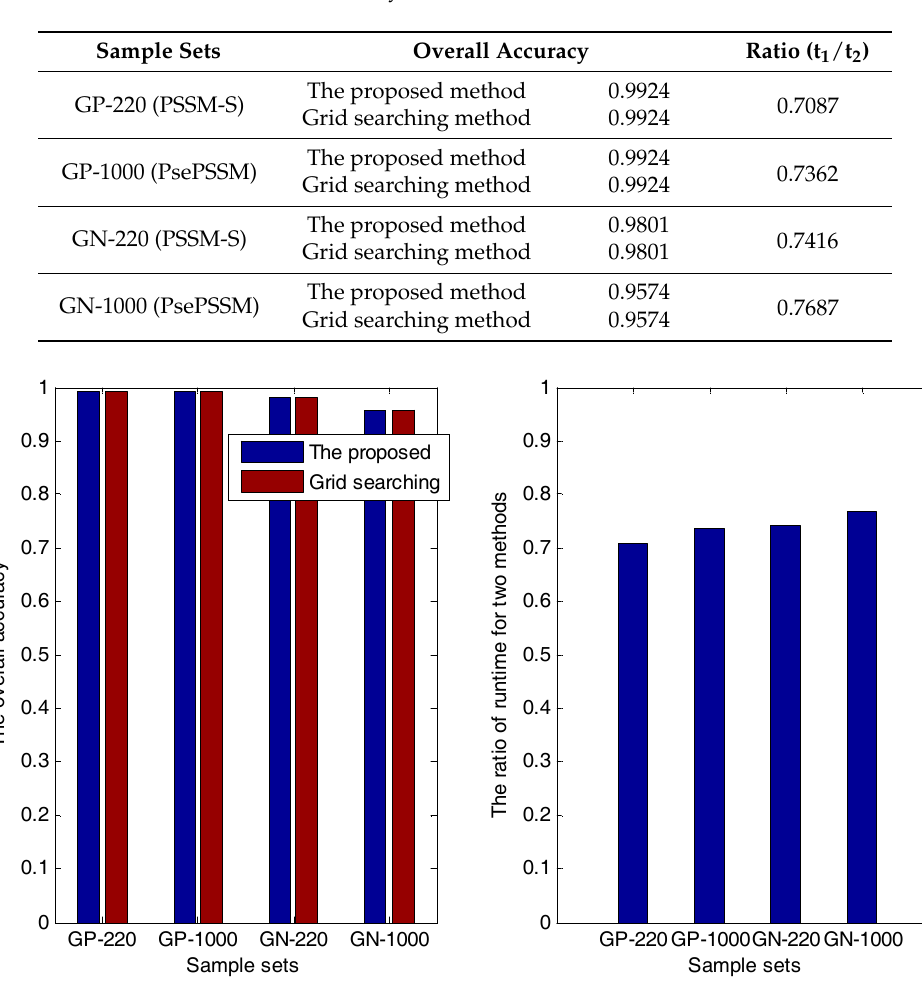
Figure 2. The overall accuracy and the ratio of runtime for two methods.